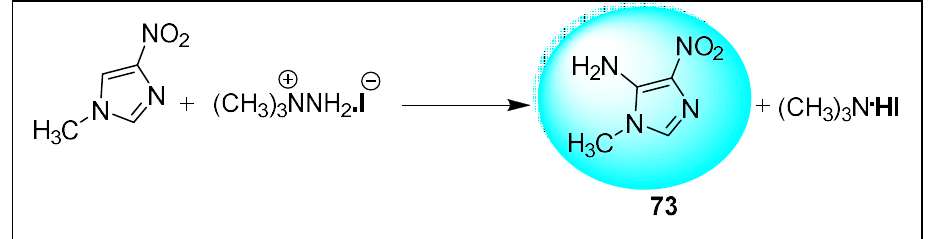
56% yield (Scheme 20) [89]. potassium tert -butylate in DMSO to produce 5-amino-1-methyl- 4-nitroimidazole 73 in